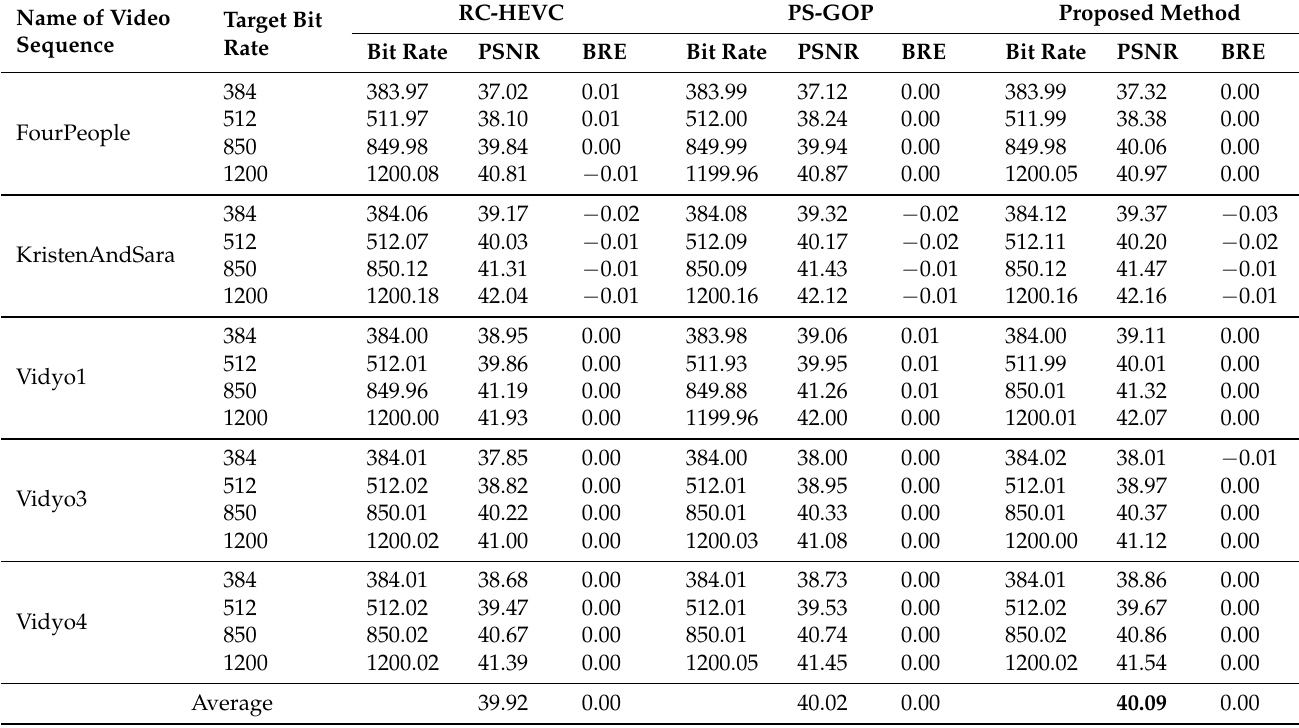
Table 4. The Performance of PSNR and BRE of Video Sequence with Resolution of 1280 ×